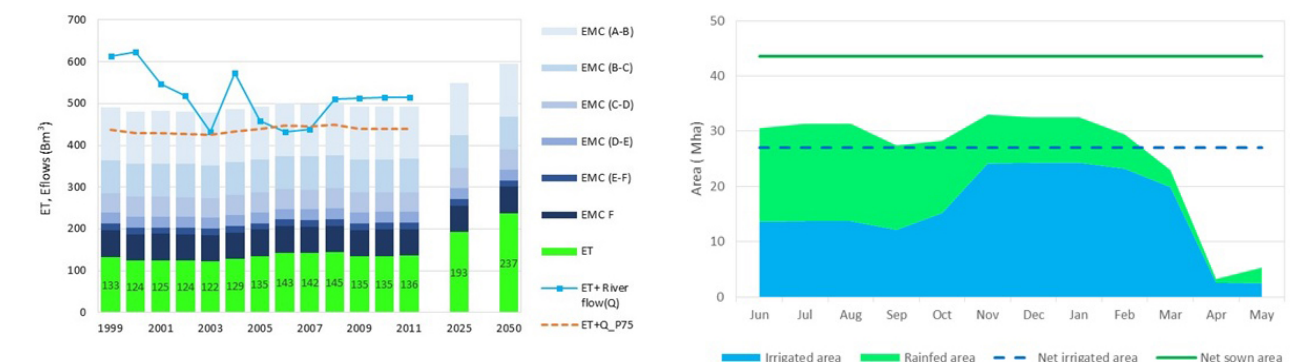
Figure 6. ET and EF estimates for different environmental manage- ment classes (EMCs). Figure 7. Monthly actual and net irrigated and cropped areas in the Ganges River basin